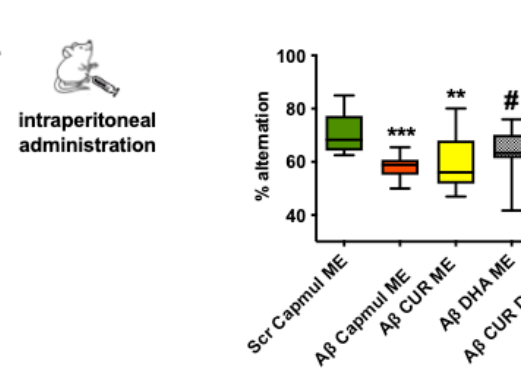
Figure 2. Effect of intranasal or intraperitoneal administration of CUR-, DHA-, and CURDHA-MEs on working memory in oA β 25–35 injected mice. ( A ) Timeline of ME administrations and Y-Maze task performed in oA β 25–35 -injected (A β ) and scrambled peptide-injected (Scr) mice. Spatial working memory was assessed in the Y-Maze 7 days after intracerebroventricular peptide injection ( B ) Effect of intranasal administration of MEs was measured the day after 4 days’ treatments (One-Way ANOVA followed by a Tukey post-hoc test, *** p < 0.001 vs. Scr mice, ### p < 0.001 vs. A β Capmul ME mice) ( C ) Effect of intraperitoneal administration of MEs was measured the day after 4 days’ treatments (One-Way ANOVA followed by a Tukey post-hoc test, *** p < 0.001, ** p < 0.01 vs. Scr mice, # p < 0.05 vs. A β Capmul ME mice). Scr and A β mice received a ME containing Capmul oil as